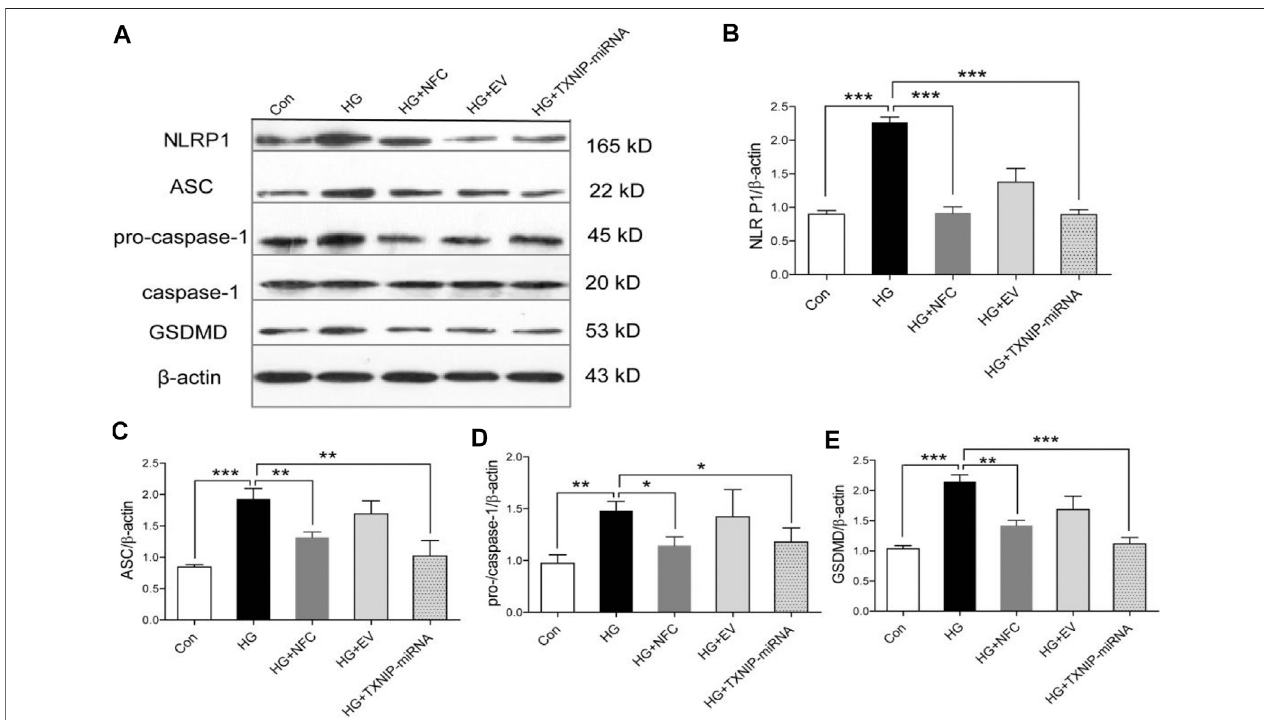
FIGURE 3 | Naofucong suppressed NLRP1/caspase-1 mediated neuronal injury in high glucose-induced HT22 hippocampal neuron cells. (A) Effects of NFC on NLRP1, ASC, pro-caspase-1, caspase-1, and GSDMD levels of HT22 cells in high glucose. (B – E) Representative protein levels of NLRP1, ASC, pro-caspase-1, caspase-1,andGSDMDlevelsofHT22cellsinhighglucosewereassessedbywesternblottingusingspeci fi cantibodies.Valuesaremeans ± SEM, n (cid:2) 4pergroup,* p